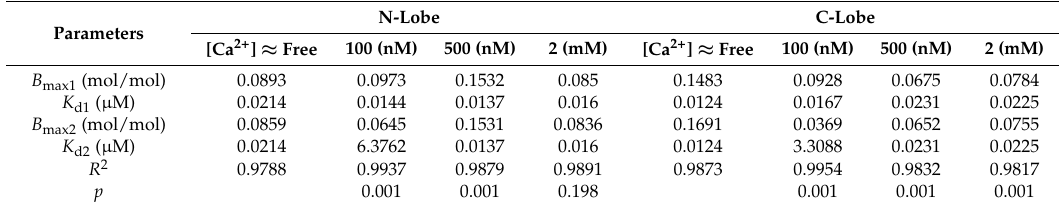
Table 2. Parameters for the bindings of truncated CaM to Na V 1.1 IQ domain.